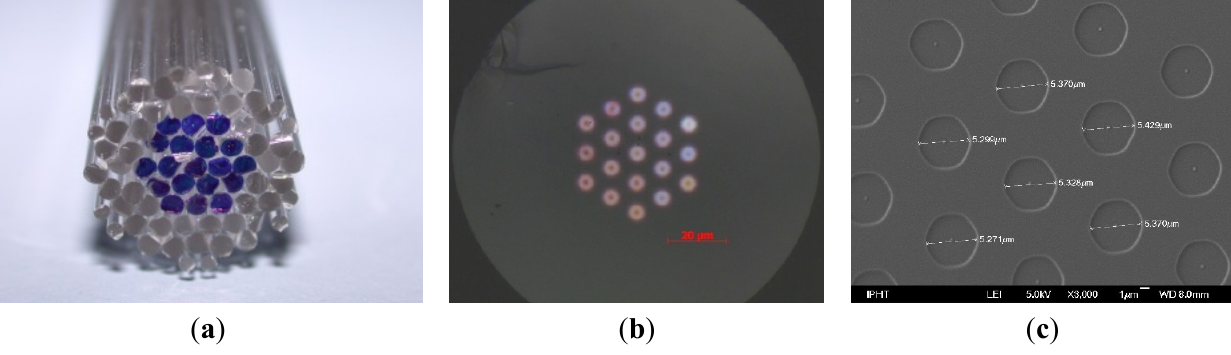
Figure 6. ( a ) Rod arrangement of the 19 core fiber: the GeO 2 doped rods are marked blue; ( b ) cross sectional view of fiber after drawing; and ( c ) scanning electron microscope (SEM)